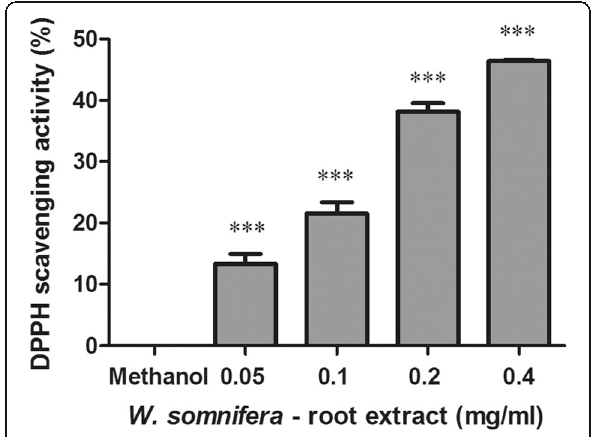
Fig. 1 Percentage DPPH scavenging activity of W RE (Values expressed as mean±SD, * p <0.05, *** p <0.0001, compared to